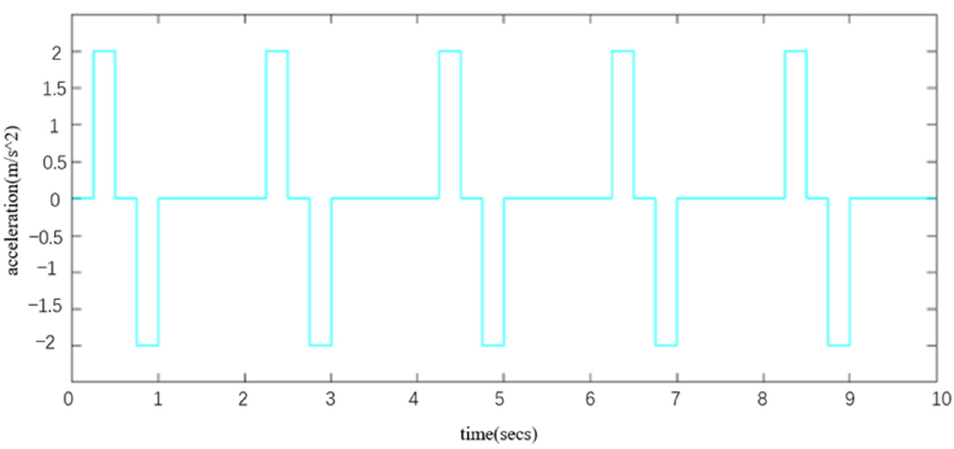
Figure 14. Input acceleration